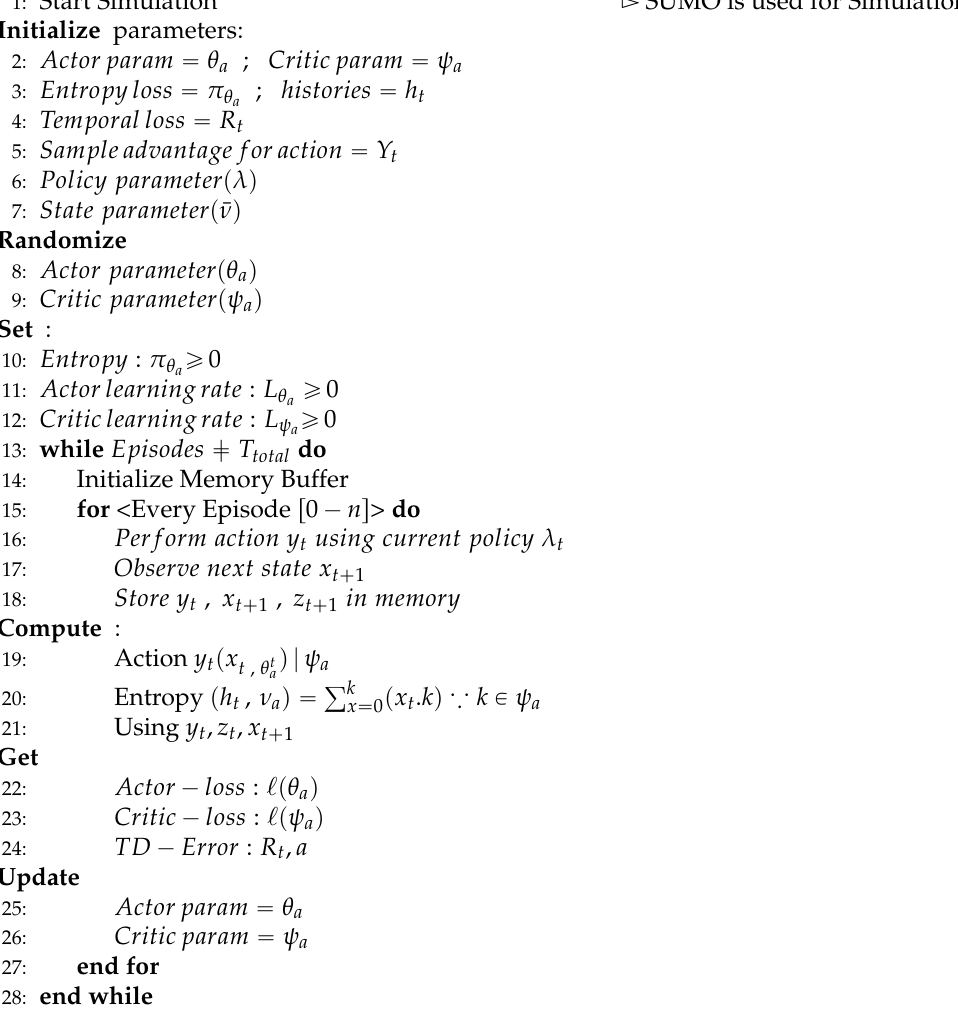
Algorithm 1 Independent Advantageous Actor Critic (IA2C) Algorithm for MARL